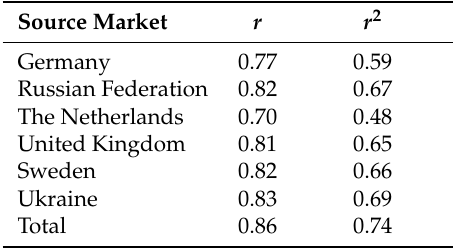
Table 5. Regression Results on the Effects of Monthly HCI:Beach-Med Scores to Visitor Arrivals (2007–2015) to